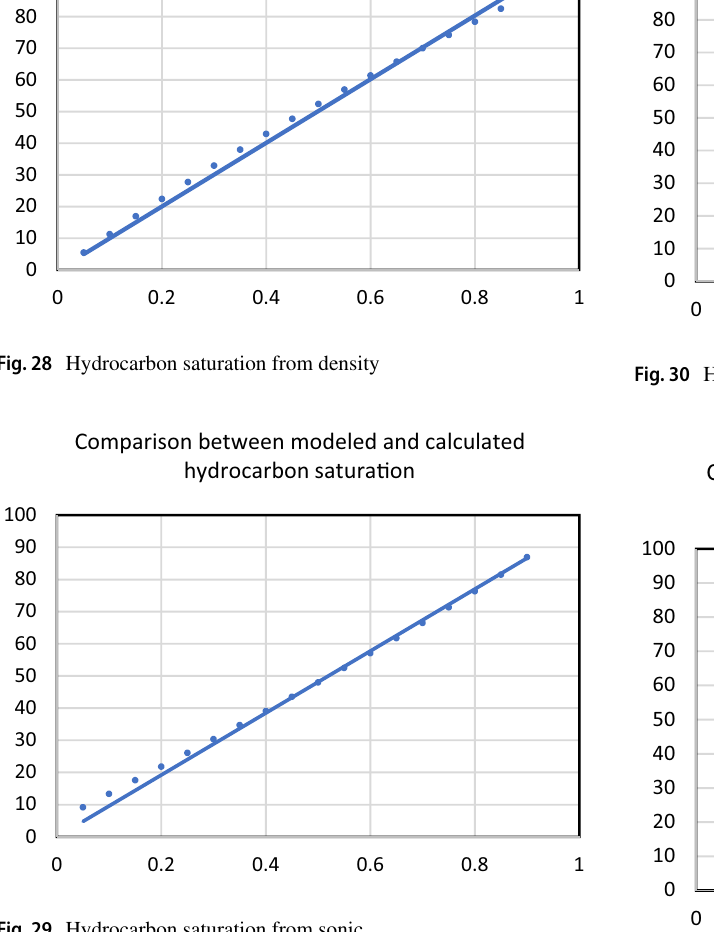
Fig. 29 Hydrocarbon saturation from sonic